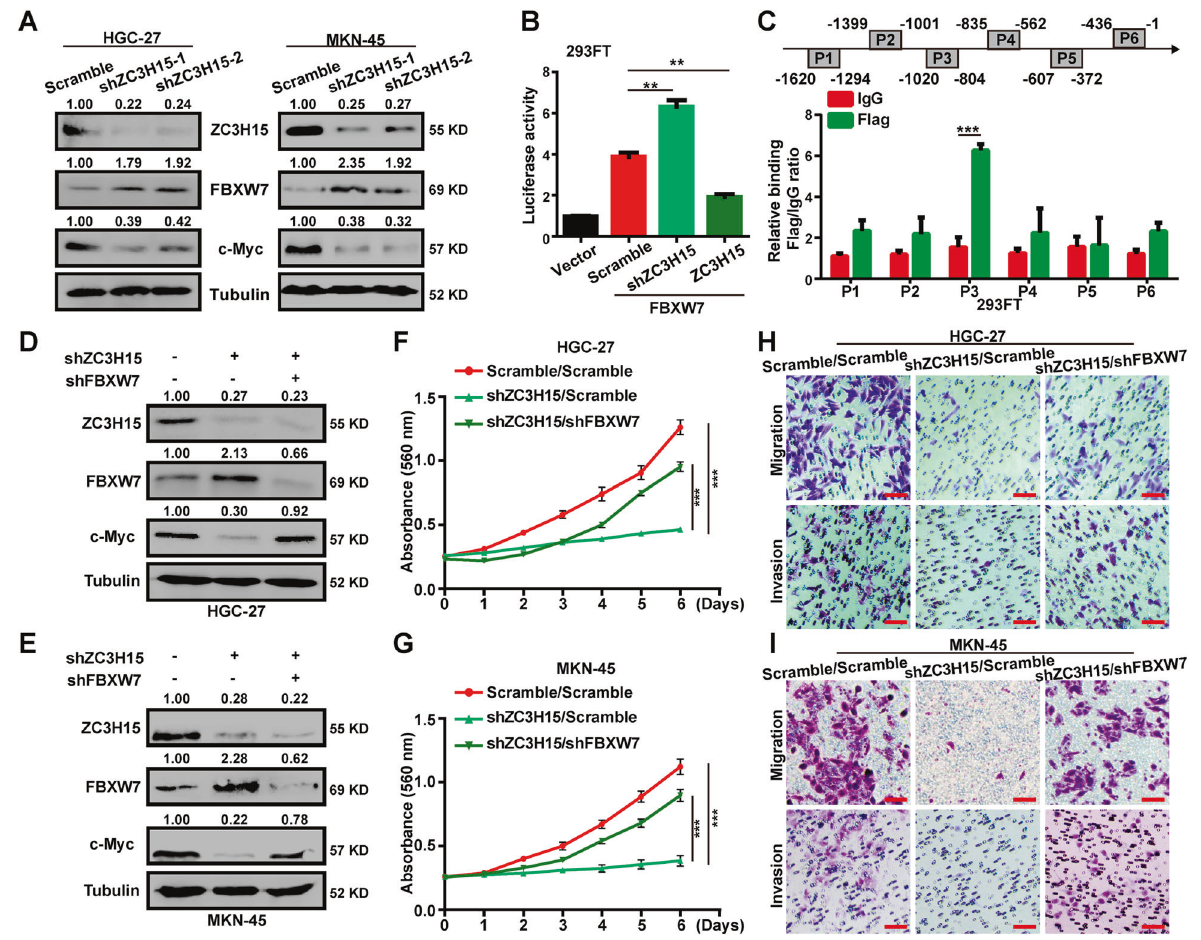
Fig. 6 ZC3H15 inhibited the transcription of FBXW7 in GC cells. A Western blot assays were used to examine the protein expression of indicated cells. B Dual-luciferase reporter assays were used to detect the promoter activity of FBXW7. C ChIP assay was performed by using Flag antibody. IgG was used as the negative control. D , E Western blot assays were performed to detect FBXW7 and c-Myc protein expression of indicated cells. F , G MTT assays were performed to detect the effects of FBXW7 downregulation on the proliferation of ZC3H15-knockdown HGC-27 and MKN-45 cells. H , I Transwell assays were performed to detect the effects of FBXW7 downregulation on the cell migration and invasion of ZC3H15-knockdown HGC-27 and MKN-45 cells. All data were expressed as mean ± SD. Student ’ s t -test was performed to analyzed signi fi cance, * P < 0.05, ** P < 0.01, *** P <